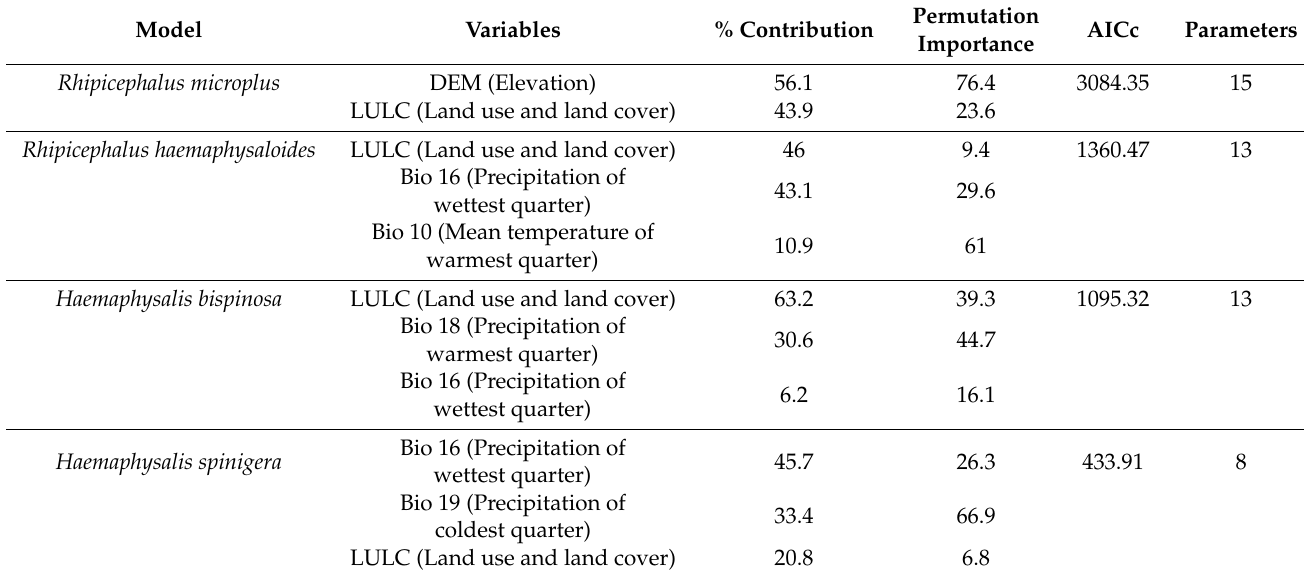
Table 7. Variable contribution, permutation importance, corrected Akaike information criteria (AICc), and number of parameters of the best MaxEnt models developed for predicting tick species occurrence in Eastern